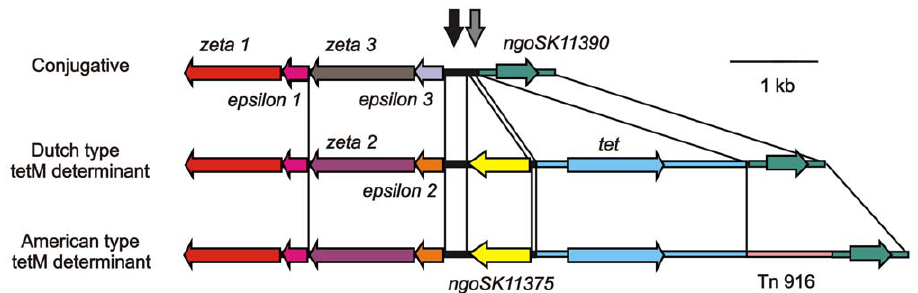
Figure 2. Comparison of the genetic loads regions of the conjugative plasmid, and the plasmids with the American and Dutch tetM determinants. The genetic load region between zeta_1 and ngoSK11390 is shown. Conserved regions are depicted in similar colors. Regions of 300 and 109 bps which are maintained after insertion of ngoSK11375 are depicted by the black and grey arrows respectively.